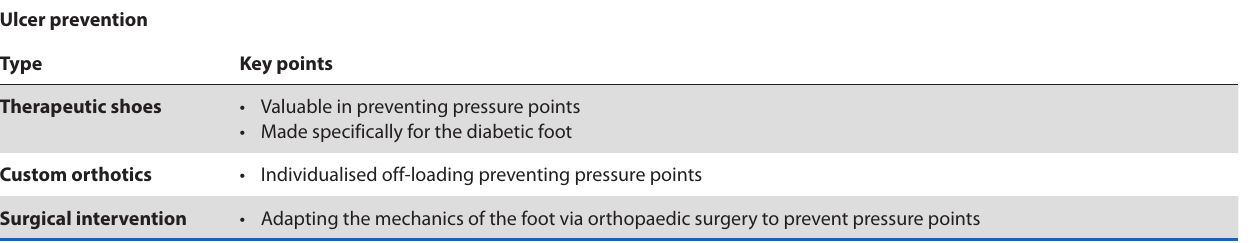
Table 6: Ulcer prevention adapted from best practice guidelines 5